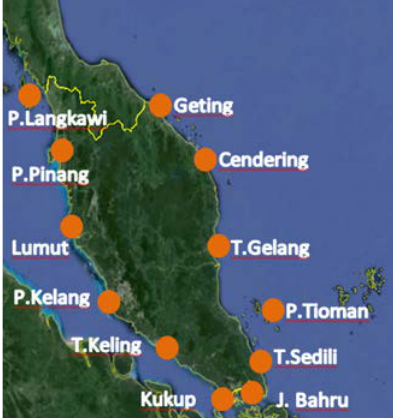
Figure 1. The distribution of tide gauge stations in Peninsular